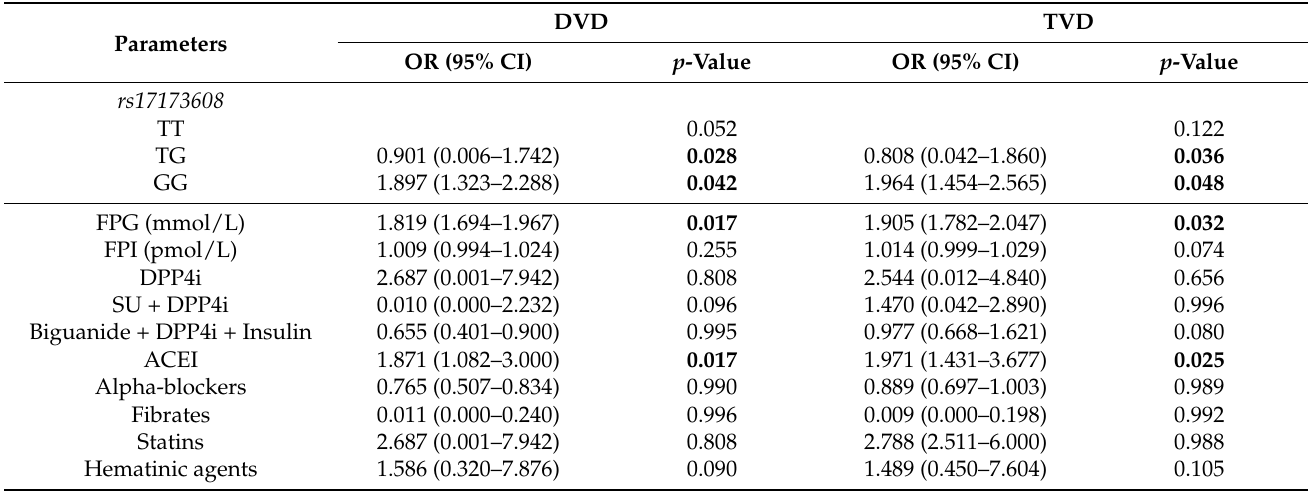
Table 6. Associations of severity of CAD in correlation with rs17173608 and clinical factors.